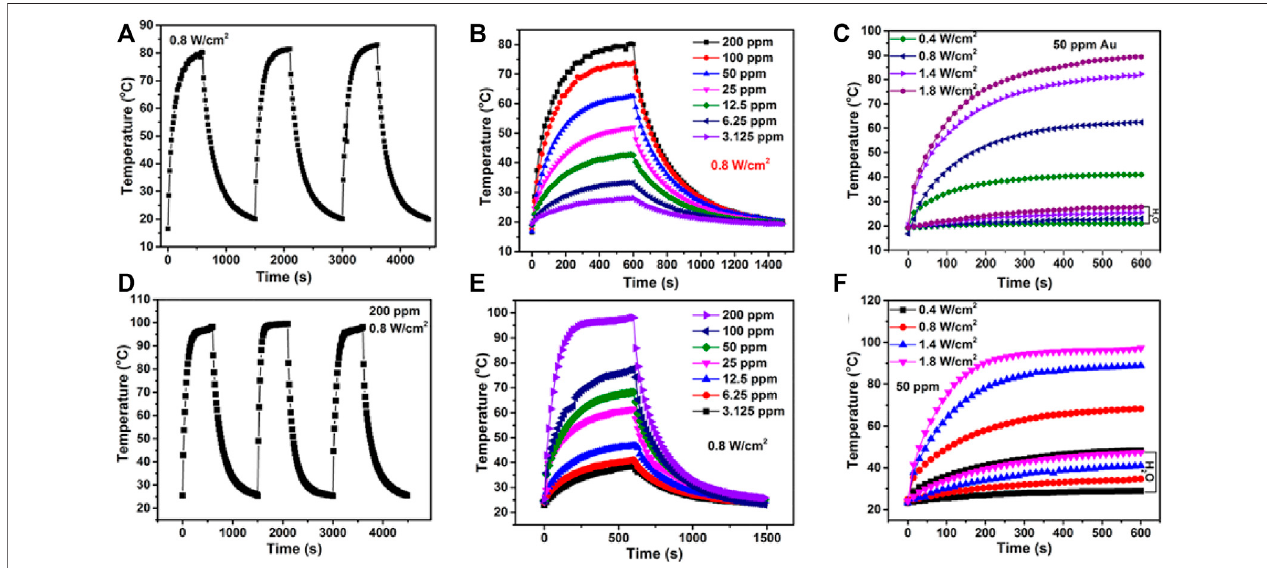
FIGURE2|(A) Heatingand coolingcirclesforAu@MOF. (B) ThephotothermalperformanceoftheAu@MOFwithdifferentconcentrationsofAuirradiated. (C) The temperature increasing and cooling curves of Au@MOF aqueous solution with concentration fi xed on 50 ppm Au. (D – F) are measured under the 1,064 nm laser irradiation, (A – C) are measured under the 808 nm laser irradiation. Reproduced with permission (Deng et al., 2019). Copyright 2019, Nano Letters.